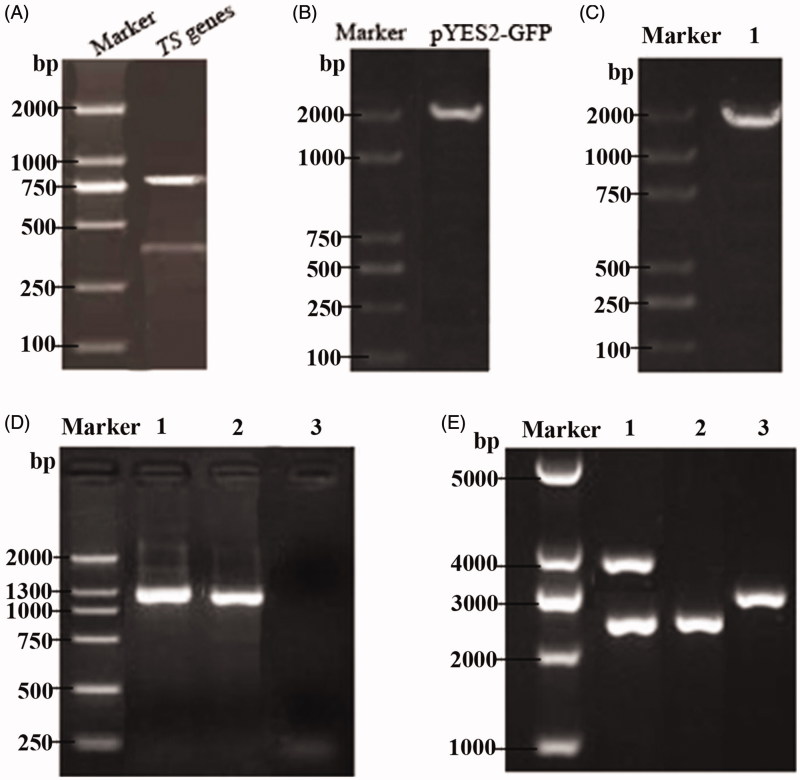
Identification of a thymidine synthase-deficient strain and its integrated pPICZ-PGK1-CCT-TS vector. (A) Agarose gel electrophoresis pattern of the upstream and downstream homologous sequences from the amplified TS gene, wherein the two bands shown are the two PCR products and represent the upstream and downstream homologous sequences of the TS gene. (B) Cloning electrophoresis identification of the GFP gene and its homologous sequences, with a size of approximately 1900 bp. (C) PCR identification of the TS gene knockout strain. Lane 1 is the GM4 strain with TS gene knockout. (D) PCR detection of the recombinant GM4-ΔTS-PGK1-CCT strain inserts CCT. Lanes 1 and 2 are the recombinant strains and lane 3 is an empty vector strain. (E) Identification of the pPICZ-PGK1-CCT-TS integration vector by double digestion. Lane 1 is the recombinant plasmid pPICZ-PGK1-CCT-TS. The results show that the upper band is an empty plasmid and a TS gene fragment, and the lower band is CCT gene fragment and the PGK1 promoter. Lane 2 is the pPICZ-rD plasmid from which the resistance gene was removed and lane 3 was pPGK1Z-rD (pPGK1Z-rD as a negative control).